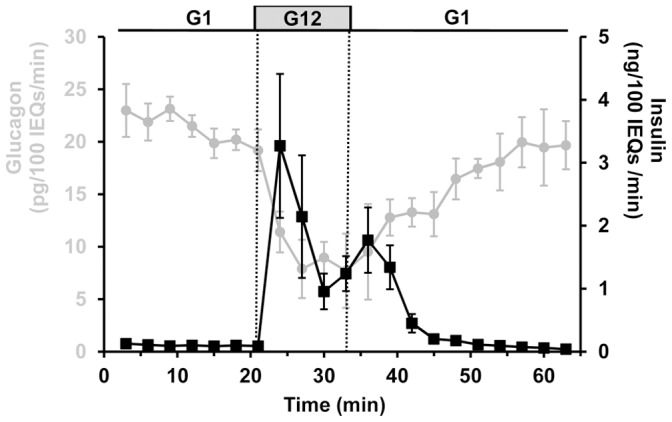
Glucose effects on hormone secretion from perifused islets.Isolated islets were exposed to 1 mM glucose for 30 minutes (from −30 to 0 min). Then, both glucagon and insulin responses (gray and black traces, respectively) were measured for 15 minutes at 1 mM glucose (G1). The perifusion was changed to 12 mM (G12) for 15 minutes, and then switched back to 1 mM. Experiment was repeated 3 times, 450 islets from 6 mice were used. Error bars represent the standard error of the mean. To compare the volume of islets with different diameters and volumes, individual islets were mathematically converted to standard islet equivalents (IEQs) with a diameter of 150 µm [44].